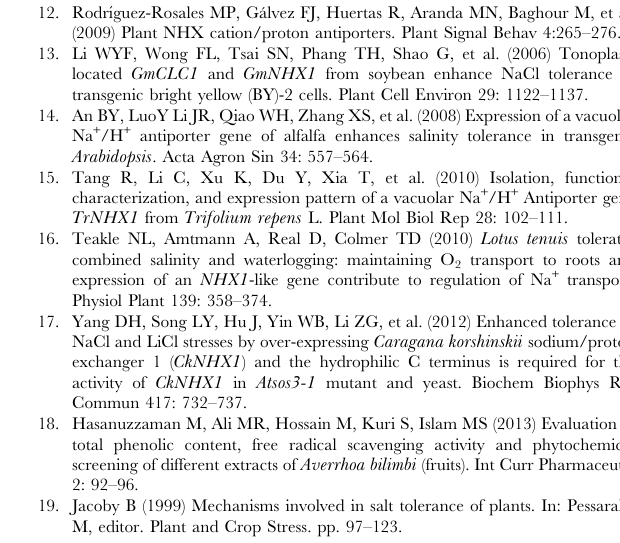
Figure S5 T-DNA region of pCAMBIA2301-35S:: VrNHX1